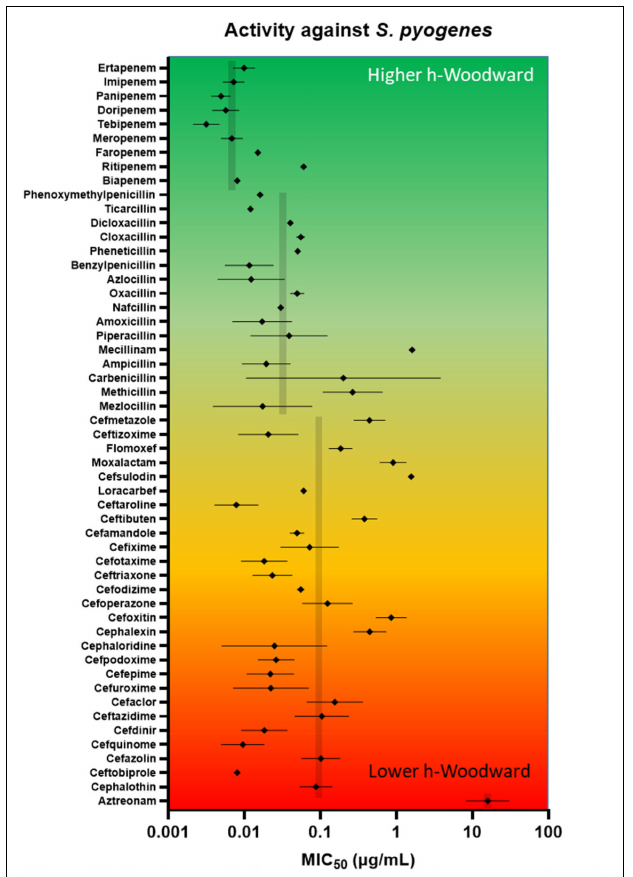
FIGURE 7 | In vitro antimicrobial activity of lactams against S. pyogenes . A review of the literature on Gram-positive β -lactam activity was conducted in which susceptibility data were gleaned from 95 studies reporting data for at least 10 strains. MIC 50 (presented as log values) were amassed, and geometric mean and geometric standard deviation were calculated. Geometric means for entire classes (e.g., penems) are shown in gray. Beta-lactams are ordered from highest h -Woodward value (ertapenem) to lowest (aztreonam).